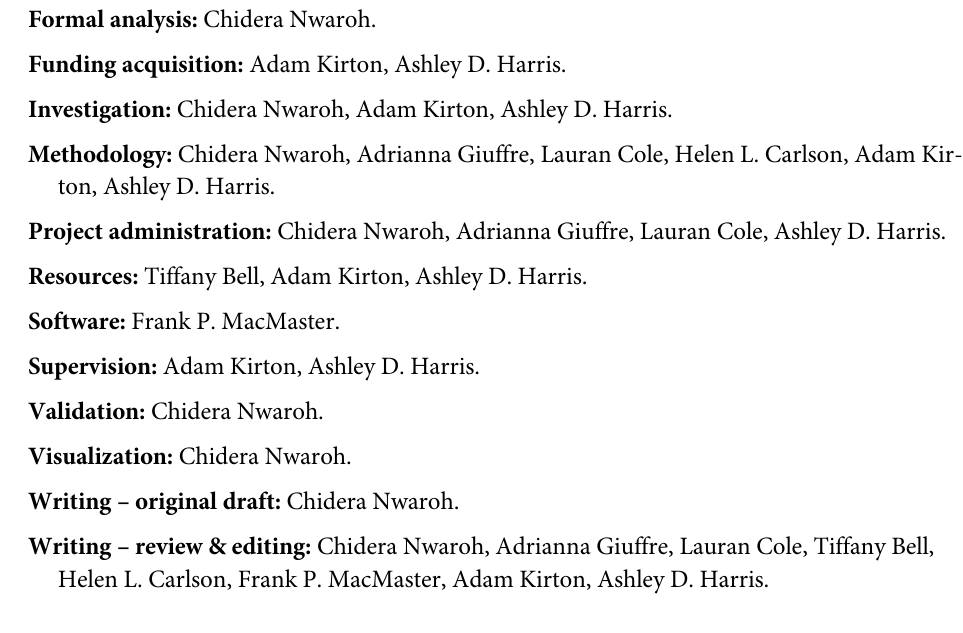
S1 Table. Tissue corrected metabolite concentrations for each intervention group ± 1 stan- dard deviation. Mean metabolite concentration for GABA and Glx in iu at three experimental time points for each intervention group; anodal tDCS (a-tDCS), anodal high definition tDCS (HD-tDCS) and